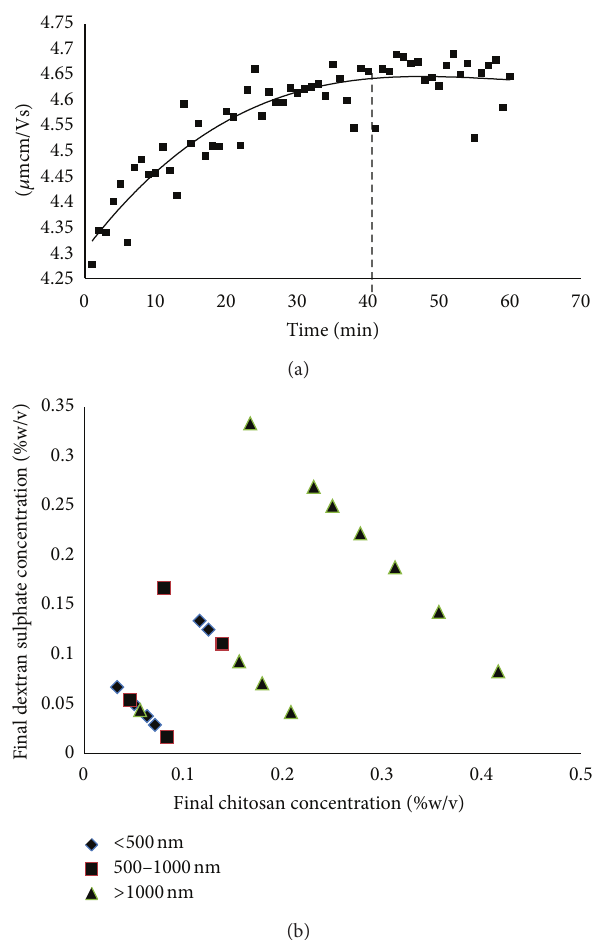
Figure 1: Electrophoretic mobility as a function of time (a) and effect of the final concentrations of CS and DS on the particle size of nanoparticles (b), 𝑛 = 3